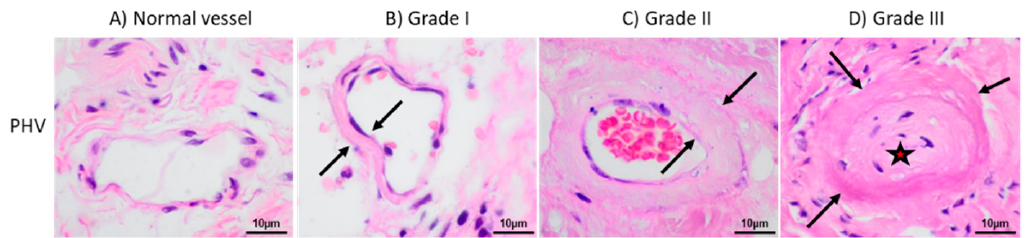
Figure 1. Images of the different grades of peritoneal hyalinizing vasculopathy (PHV). ( A ) Normal vessel showing no thickening. ( B ) Grade I is characterized by minimal thickening (area between arrows) with no luminal obliteration. ( C ) In grade II lesions, the thickening is moderate (area between arrows) and luminal narrowing is present. ( D ) Grade III lesion showing intense thickening (arrows indicate vascular external limit) with trapped cells and complete luminal obliteration (red star).